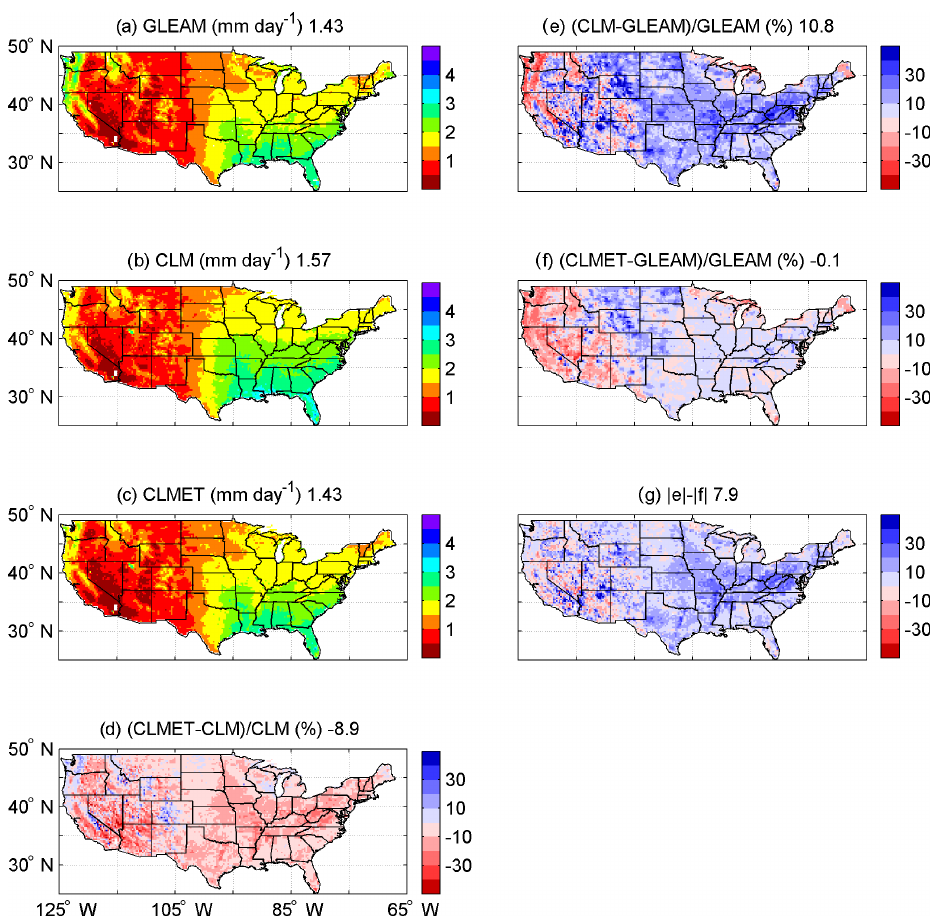
Figure 3. Mean annual ET from (a) GLEAM, (b) the CLM, and (c) CLMET, the relative difference between (d) CLMET and the CLM, (e) the CLM and GLEAM, (f) CLMET and GLEAM, and (g) the difference between the absolute value of (e) and the absolute value of (f) during the period 2000–2014. Numbers in titles are CONUS-averaged